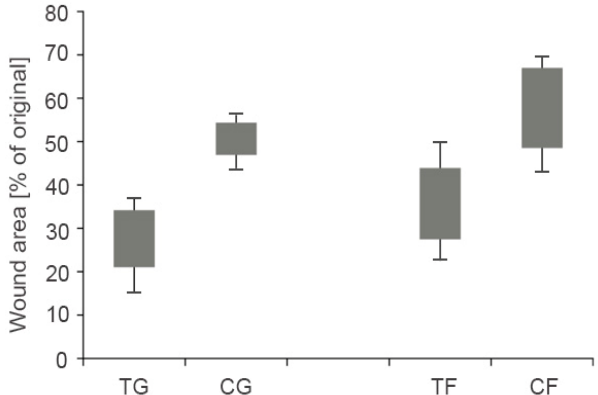
Figure 6. Overview of the wound area comparing thiolated carboxymethyl HA film and gel studied on rats. Wound area calculated in percent referring to the original wound area. Gel (TG) and film (TF) treatments compared with untreated controls (CG and CF) on day 7 after wounding. Bars represent 95% confidence intervals of the means; lines represent the range of values obtained. Adapted from Yang et al. [35].